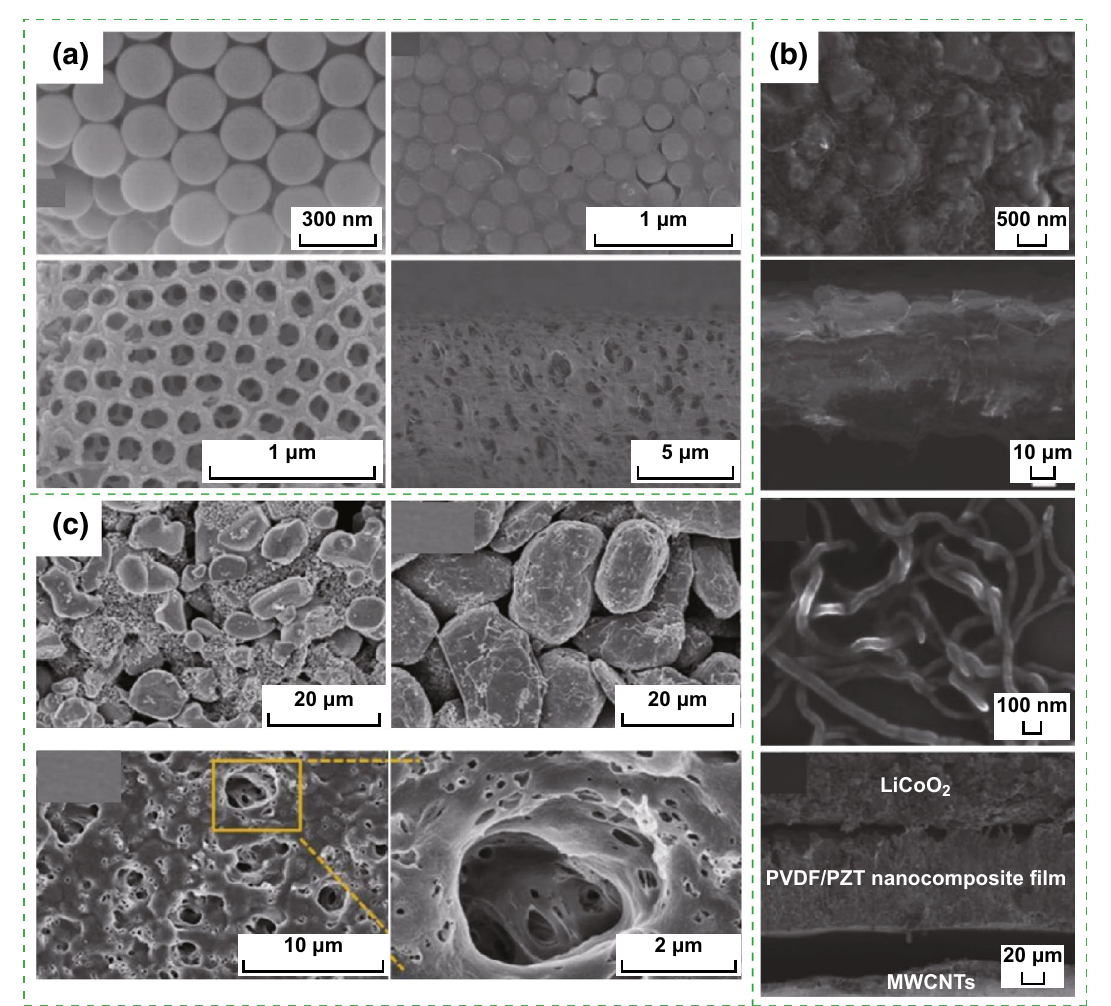
Fig. 1 a SEM images of SiO 2 microspheres, SiO 2 ‑PVDF composite film, mesoporous PVDF film after removing SiO 2 microspheres on the top view, and the mesoporous PVDF film on the side view. Reprinted with permission from Ref. [11]. b FESEM images of the PVDF–PZT nano‑ composite film, FESEM image of the PVDF–PZT nanocomposite film, FESEM image of MWCNTs, and cross‑sectional FESEM image of the SCPC device